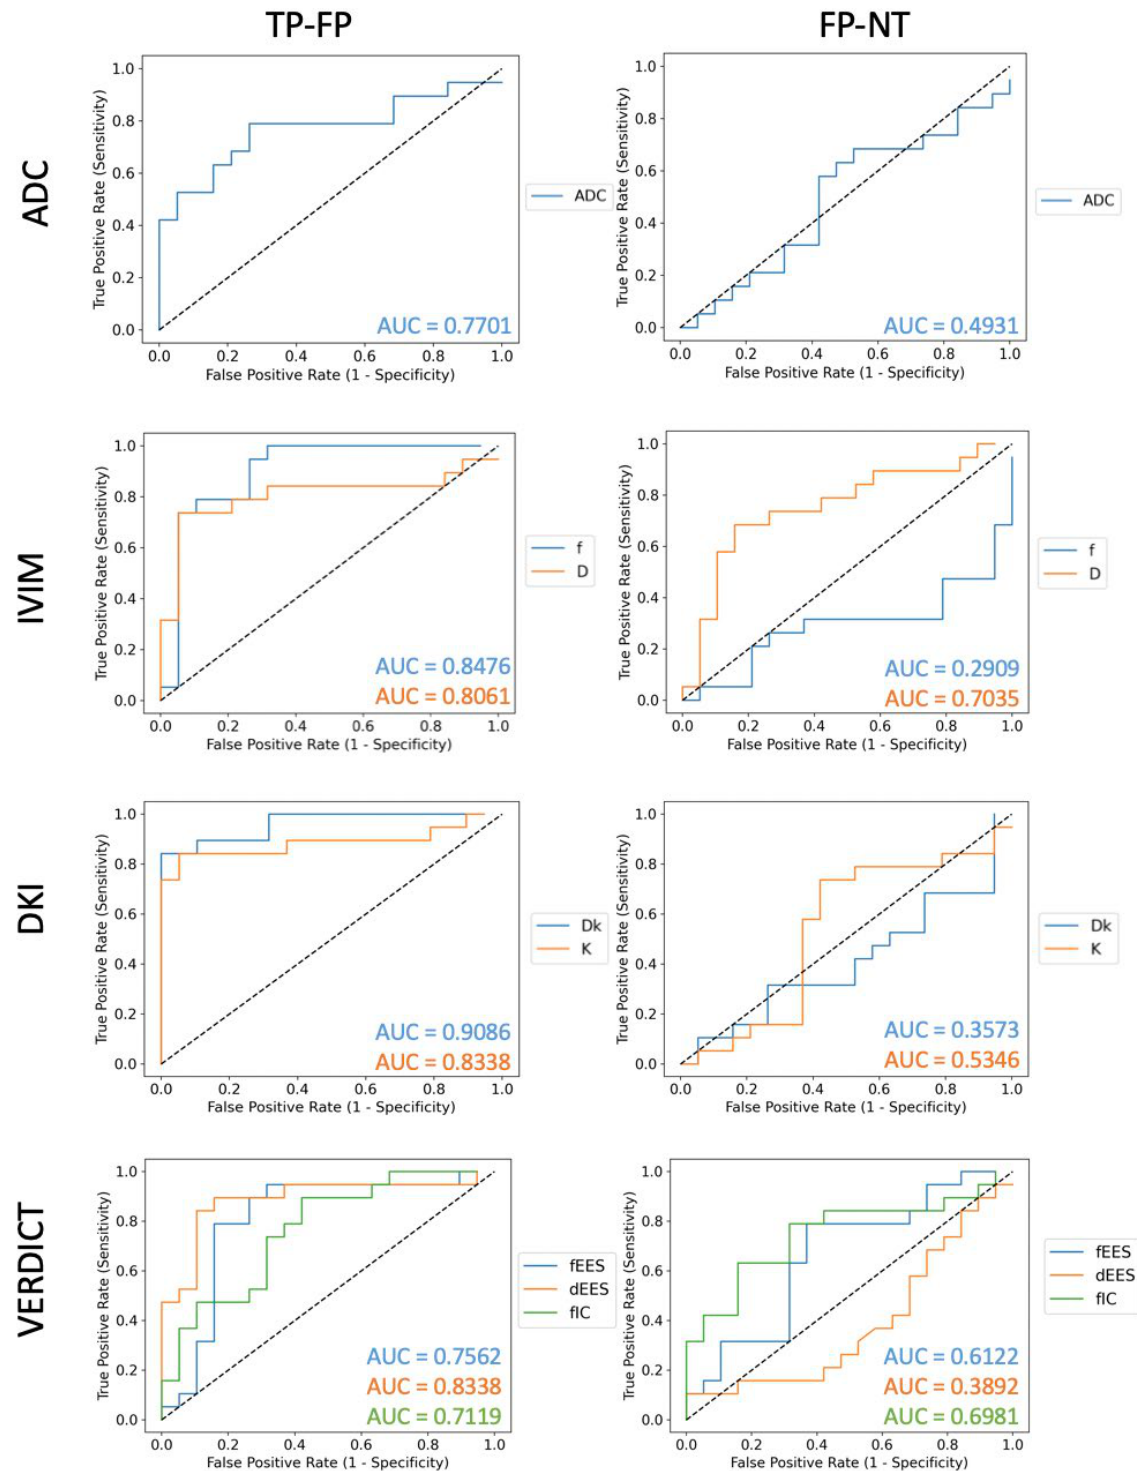
Figure 4. ROC curves for ADC, DKI, IVIM and VERDICT parameters—those on the left are for discriminating true (TP) and false positives (FP), and those on the right are for discriminating false positives and normal tissue (NT). We observed that the largest AUC for discrimination between true and false positives is achieved by the DKI D K (AUC = 0.9086). The largest AUC for discrimination between false positives and normal tissue is achieved by the IVIM D (AUC = 0.7036), closely followed by the VERDICT f IC (AUC = 0.6981).